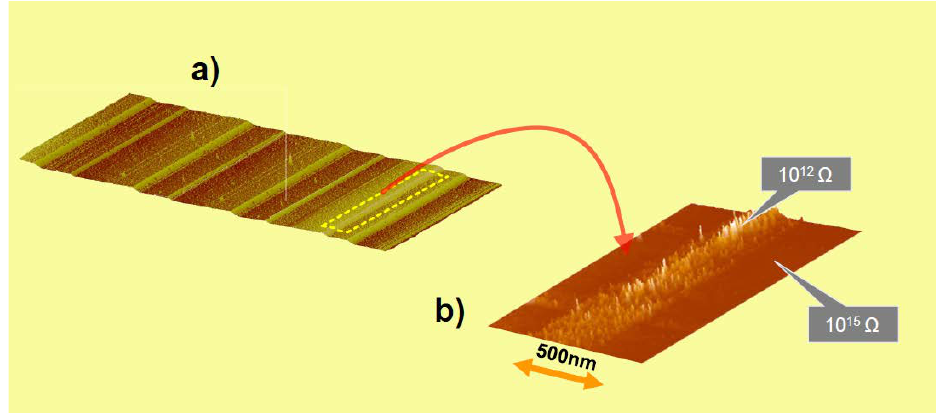
Figure 37. AFM and LCAFM measurements of plastically deformed single crystals of SrTiO 3 . ( a ) AFM topography after plastic deformation; ( b ) LCAFM conductivity maps at a deformed step. Adapted from [68].